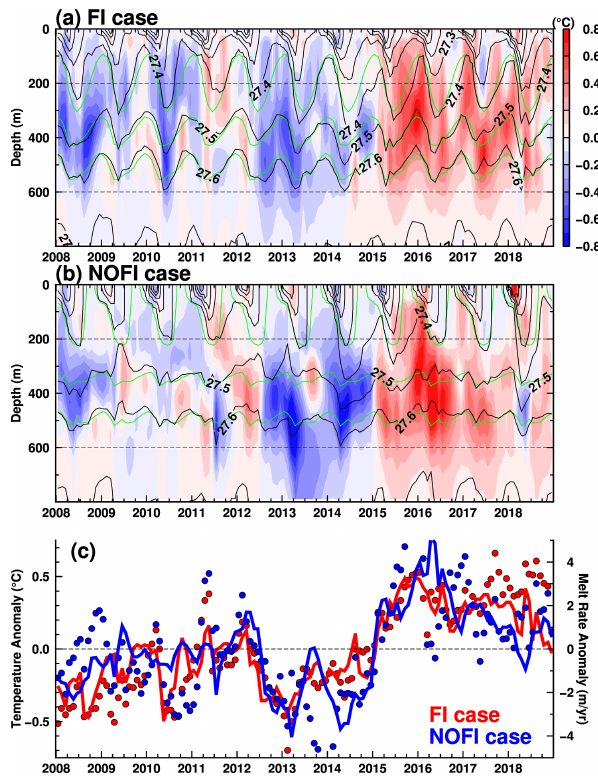
Figure 20. Time series of ocean temperature anomaly and potential density averaged over the box area in Fig. 8 ( a : vertical profile in the FI case; b : vertical profile in the NOFI case; c : 200–600m averaged temperature) and the SGT melt rate anomaly (dots in panel c ). The anomalies are deviations from the monthly climatologies averaged over the period 2008–2018. Green curves in panels (a) and (b) are climatologies of the potential